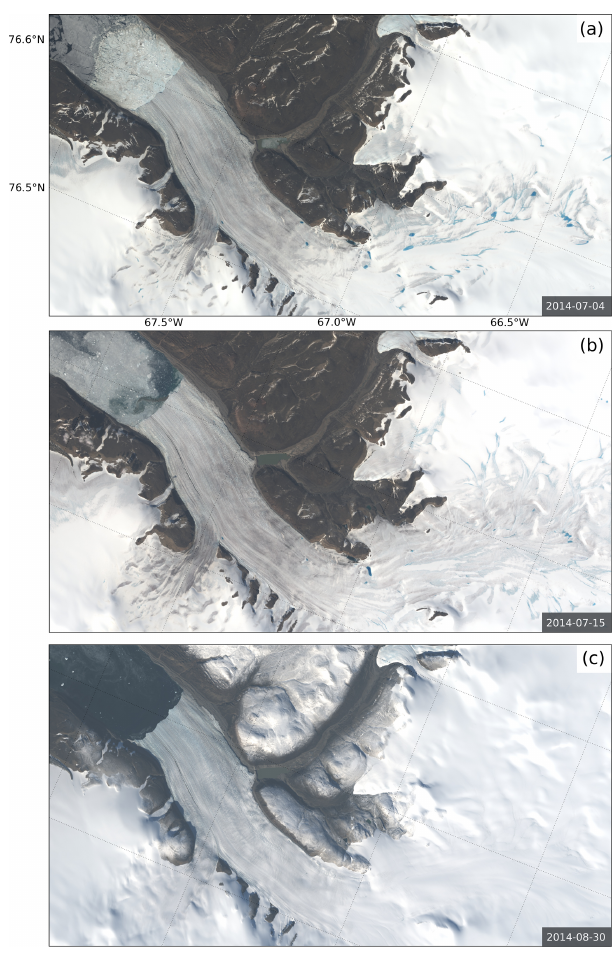
Figure E1. Exemplary three different Landsat scenes during the phase of highly variable flow velocities in summer 2014 (USGS,